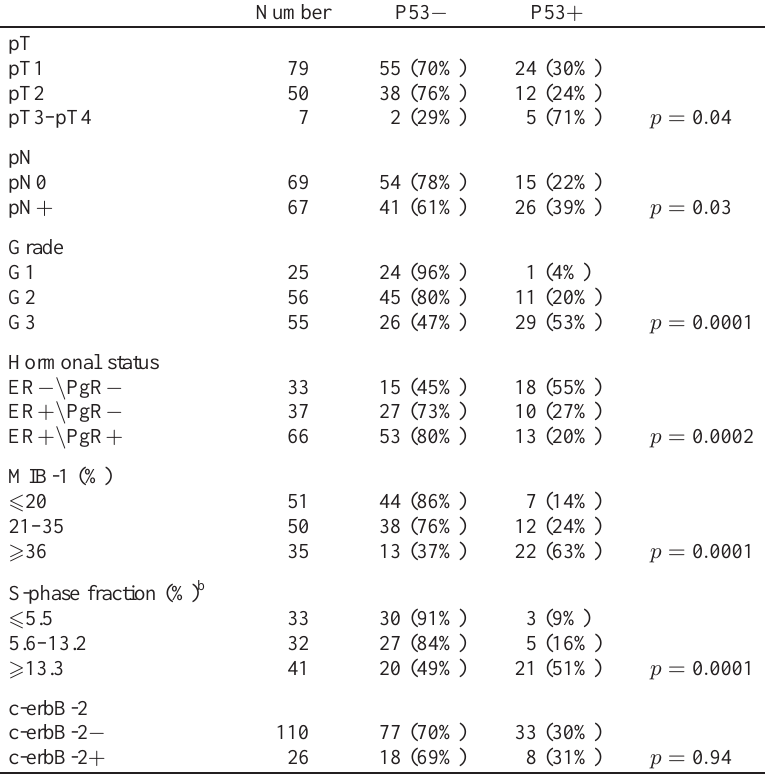
Table 4 P53 immunoreactivity correlated to clinico-morphologic and biologic parameters